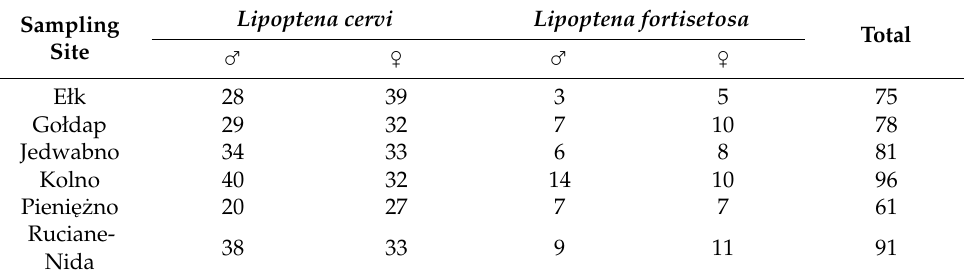
Table 1. Number of deer keds collected in sampling sites, with a division into species and